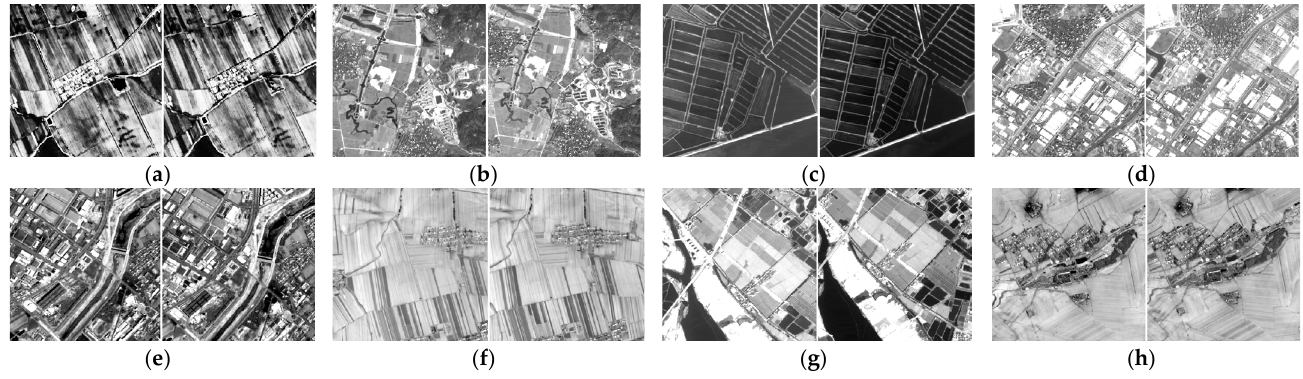
Figure 7. The image patches selected from the ZY-3 satellite images. Farmland ( a , f ); countryside ( b , h ); paddy fields ( c , g ); buildings ( d , e ).